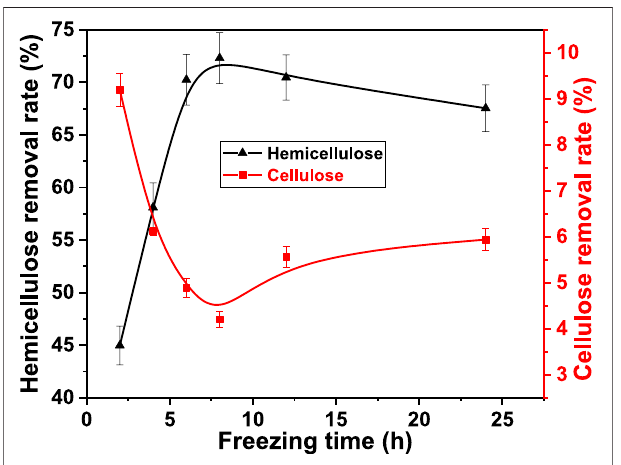
FIGURE 3 | Effect of alkali concentration on the removal rate of cellulose and hemicellulose from bagasse fi ber in FT/AT.